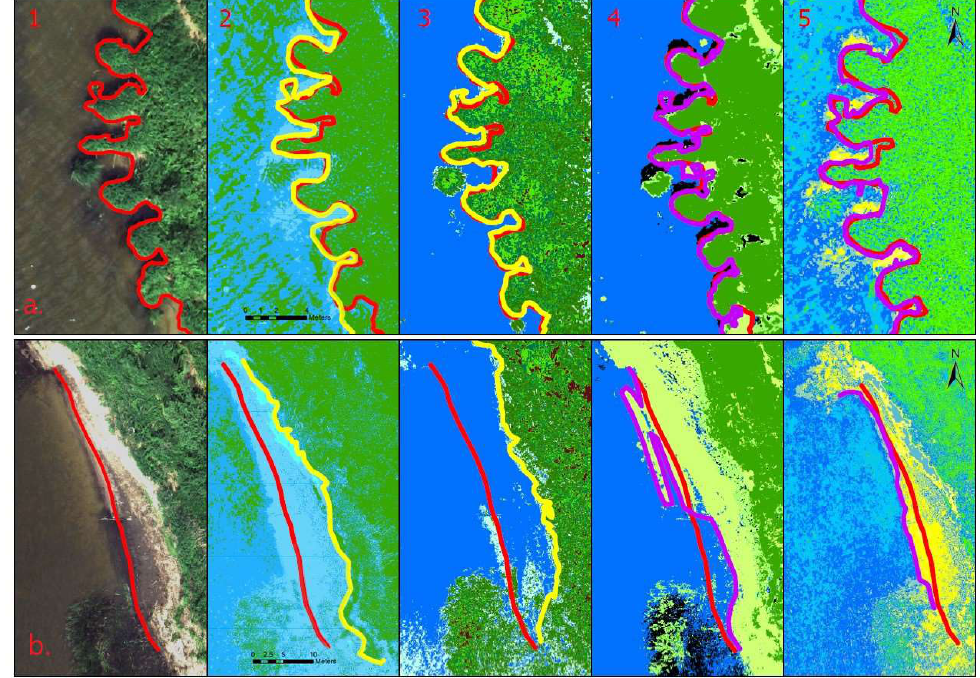
Figure 3. Comparison of the different shoreline detection techniques in different shore conditions: ( a )—reservoir banks are steep with land vegetation covering them; ( b )—very shallow sandy shores. 1—Orthomosaic of the area with the shoreline marked as a red line (it stays in the other pictures as a reference). 2—Classified raster containing NGRDI values with the shoreline marked as a yellow line. 3—Classified raster containing NDWI values with the shoreline marked as a yellow line. 4—Classified multispectral orthomosaic with the shoreline marked as a magenta line. 5—NGRDI thresholding with the shoreline marked as a magenta line.